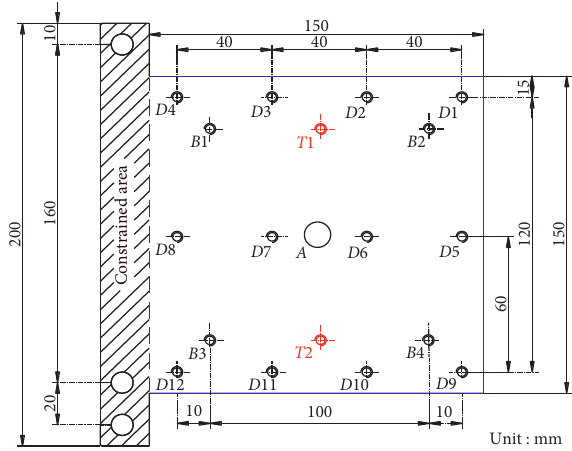
Figure 3: Dimensions of the baseplate. Table 4: Thermophysical properties of the 45 steel.